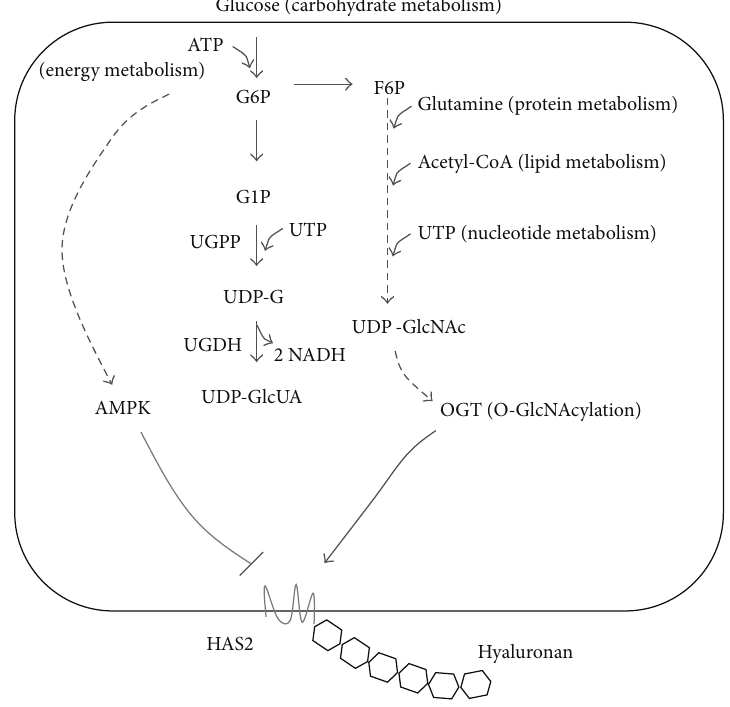
Figure 1: HA precursors biosynthesis and main HAS2 regulation in SMCs. Glucose enters in the cells and is phosphorylated by ATP. Glucose 6 phosphate (G6P) can be converted into glucose 1 phosphate (G1P), UDP-glucose (UDP-G), and UDP-glucuronic acid (UDP-GlcUA) by the enzymatic reactions catalyzed by UDP-G pyrophosphorylase (UGPP) and UDP-G dehydrogenase (UGDH). This latter reaction produces 2 NADH. G6P can enter in the hexosamine biosynthetic pathway, which starts from fructose 6 phosphate (F6P) and, in several steps, produces UDP-N-acetylglucosamine (UDP-GlcNAc). These steps depend on carbohydrates, energy, proteins, lipids, and nucleotides metabolisms makingUDP-GlcNAcamasternutrientsensor.AMPKinconditionofATPdepletion(oractivationbymetformin)inhibitsHAS2bythreonine 110 phosphorylation. An increment of UDP-GlcNAc induces O-GlcNAcylation of serine 221 of HAS2 by OGT. This glycosylation strongly stabilizes HAS2 protein avoiding its